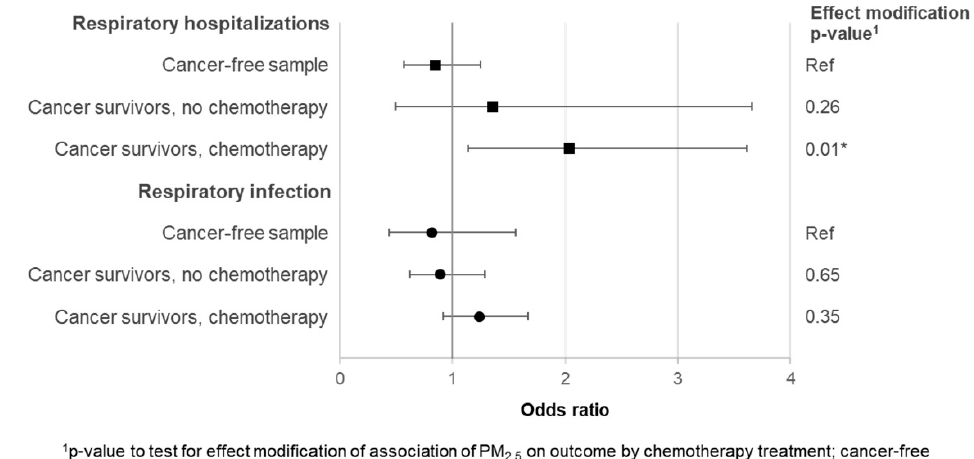
Figure 1. Comparison of odds ratios and 95% confidence intervals (CI) for the association of PM 2.5 and respiratory events between survivors of childhood cancers and a cancer-free sample.